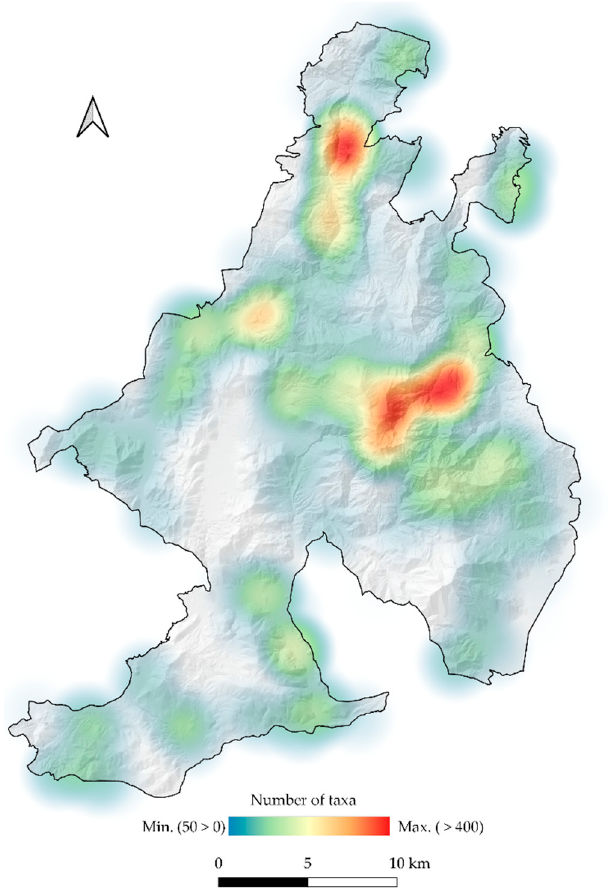
Figure 2. Floristic diversity hotspots in the CVNP